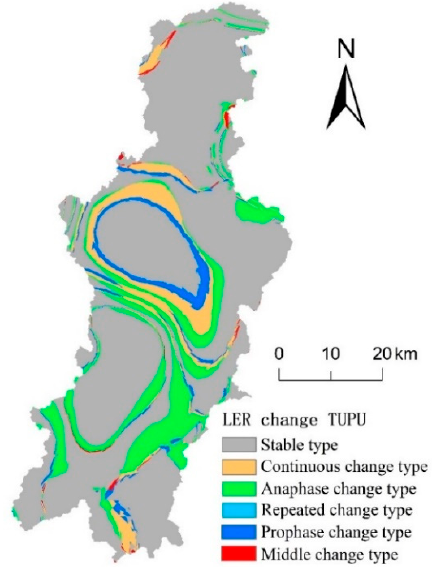
Figure 5. Spatial distribution of LER change Tupu in the Dianchi Lake basin.